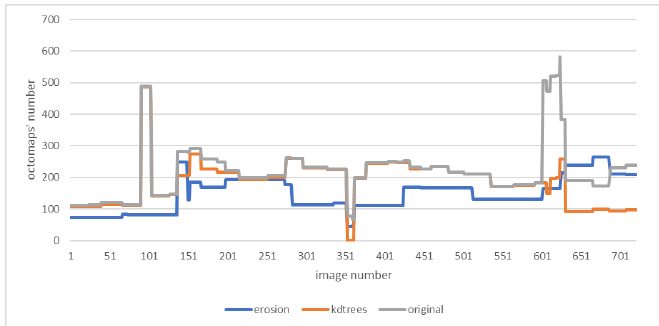
Figure 8. Comparison of different methods. Differences in the amount of detected octomaps on each image are shown in Figure 9.